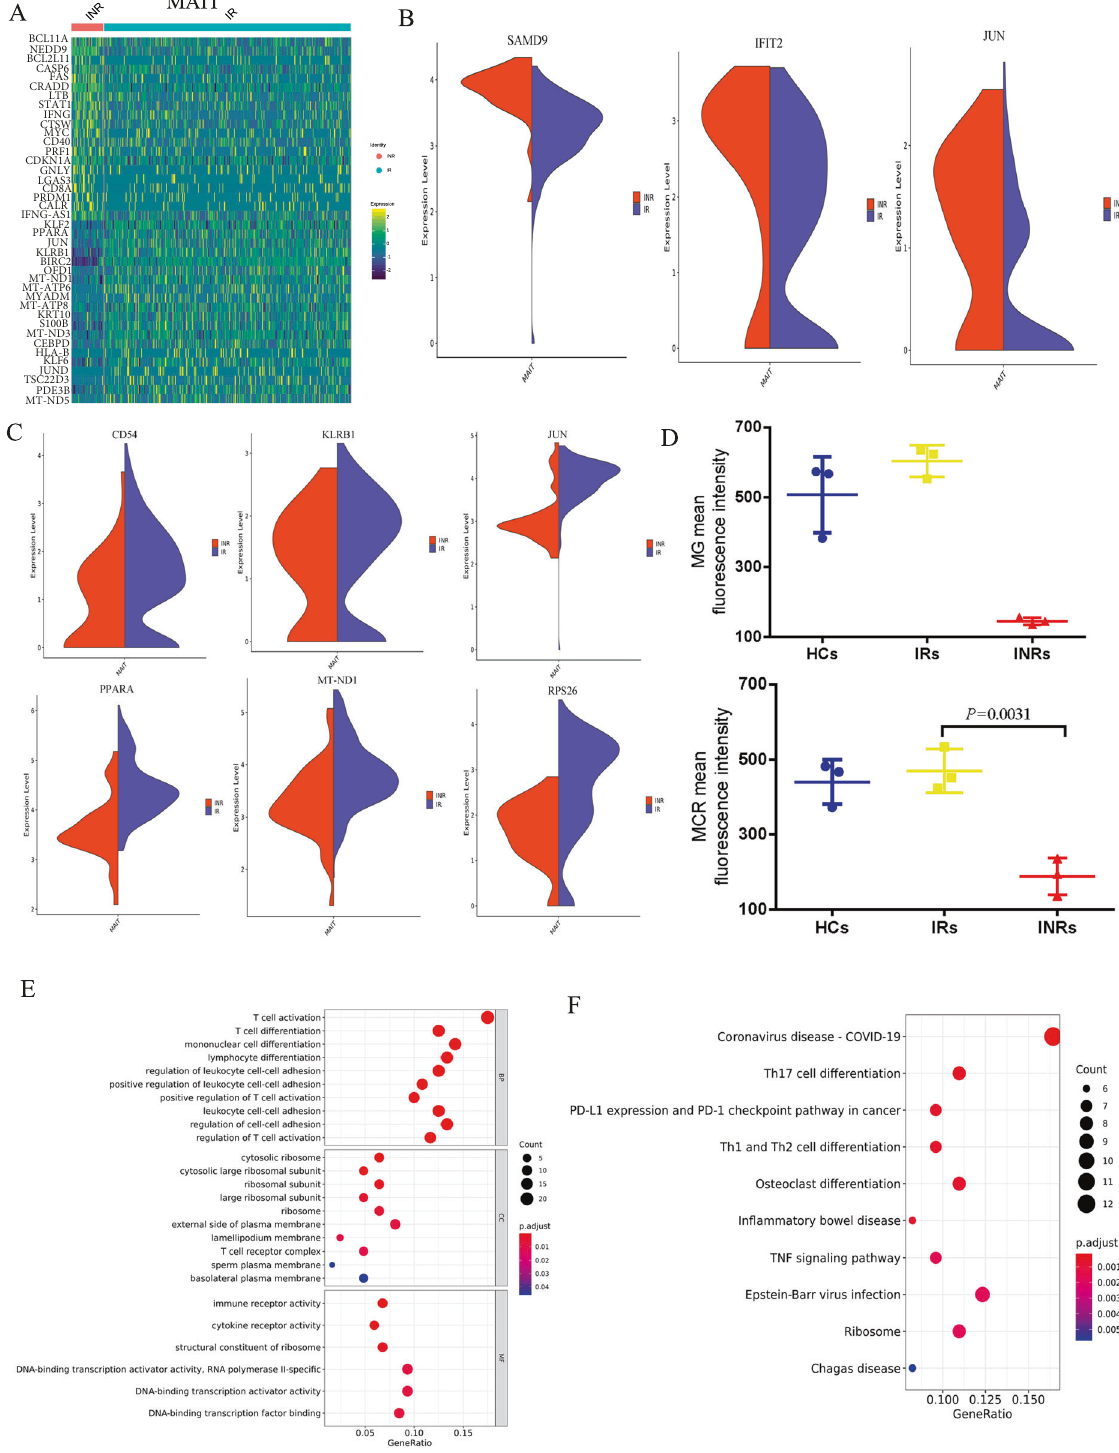
Fig. 3 The apoptotic gene expression pro fi le of MAIT cells derived from INR. A Heatmaps of differentially expressed genes in MAIT cells between IR and INR groups. B Violin plots of the proapoptotic gene expression in MAIT cells from INRs and IRs. C Violin plots of mitochondrial function-related gene expression in MAIT cells from INRs and IRs. D Mitochondrial mass and mitochondrial membrane potential are estimated by MG fl uorescence and MRC fl uorescence in MAIT cells from INRs and IRs, respectively. E , F GO and KEGG analyses conducted using DAVID for upregulated genes in MAIT cells from INRs compared with